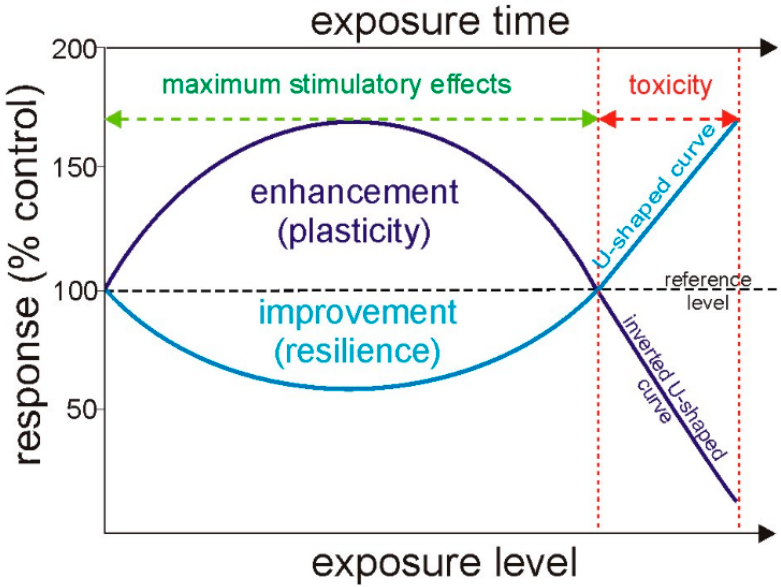
Figure 2. Graphical presentation of the hormesis concept. Dose-response curves showing the changes in biological responses to treatment (exposure level) with time (exposure time) in relation to a reference group (% control). Response that may refer to both beneficial and deleterious effects is calculated according to the formula: response = p c / p t × 100, where p c is the mean value of the tested parameter ( p ) in the control group and p t is the mean value of p in the treated group expressed in percentage. The regions of enhancement/improvement as well as adverse or toxic effects are also presented. Enhancement (plasticity) is the ability of organism to survive by the acclimatization to nascent conditions, while improvement (resilience) refers to organism recovering by quick repair of appearing damage. Modified from Agathokleous [105].